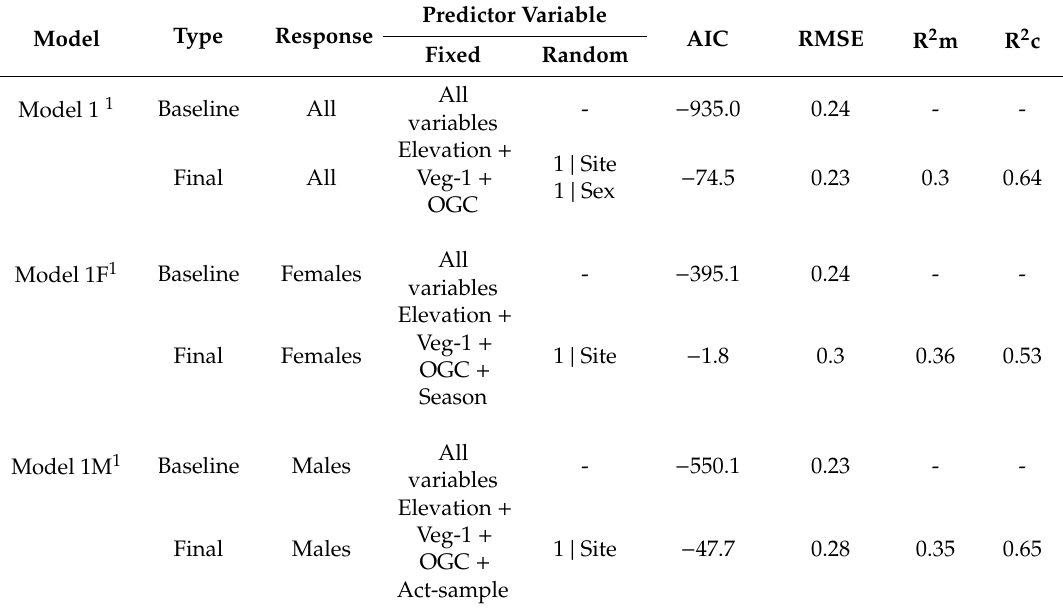
Table 2. Model selection to explain the patterns of body size in the ground beetle Amara alpina .